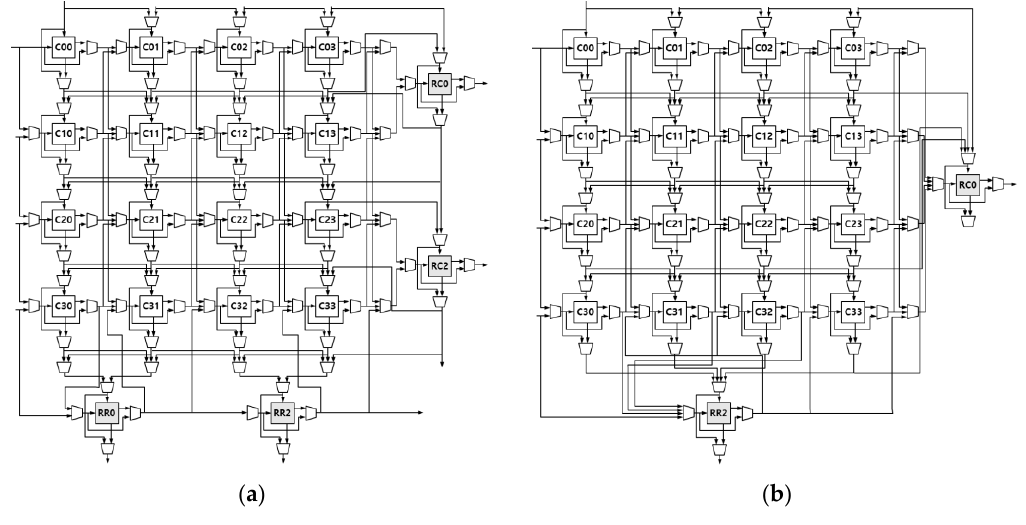
Figure 4. Proposed redundancy architecture: ( a ) OL 2; ( b ) OL 4.